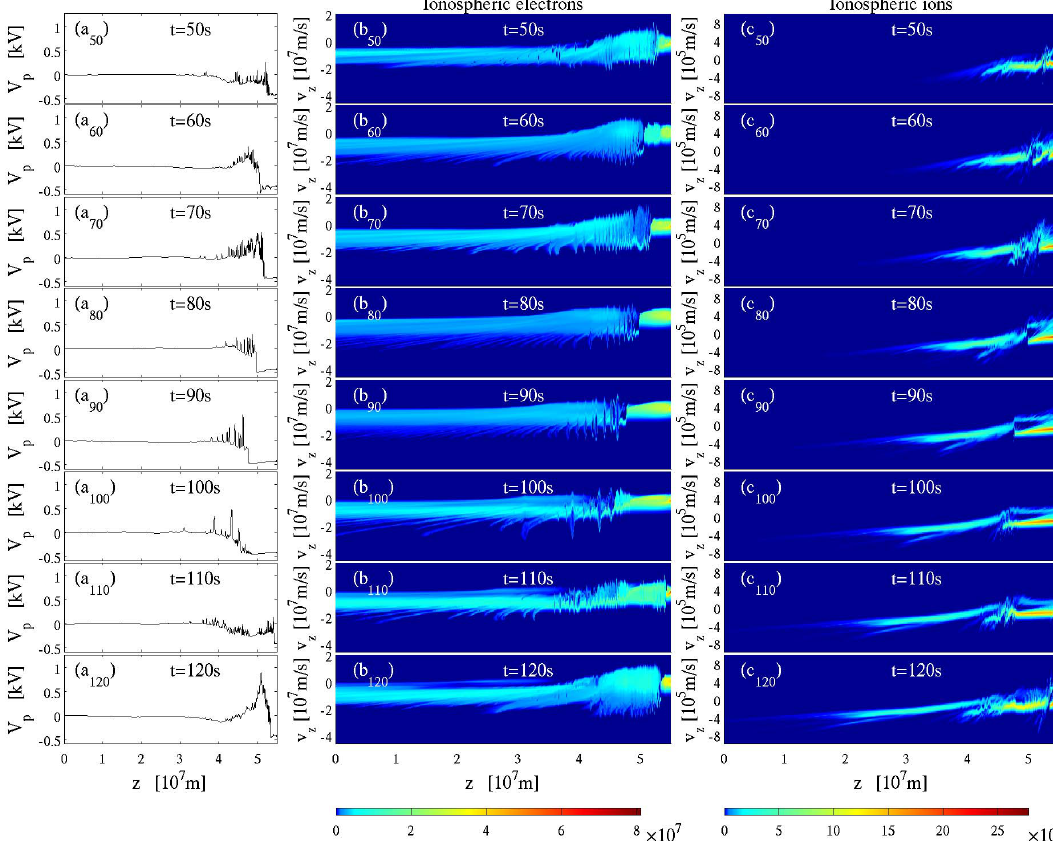
Figure 4. Plasma potential and phase space densities for the ionospheric species in the run with V p , I = − 400V and 4 × 10 7 m − 3 . (a) Plasma potential V p (z) . (b) Phase space density f e , I (z,v z ) of ionospheric electrons. (c) Phase space f i , I (z,v z ) of ionospheric ions. The colour scales have been normalised so that integrals over all v z are equal to n s /B , where n s denotes the density of species in question, and the unit for f (z,v z ) is m − 4 T − 1 s. The subscript of the panel label indicates the number of seconds for which the distribution function is shown in that